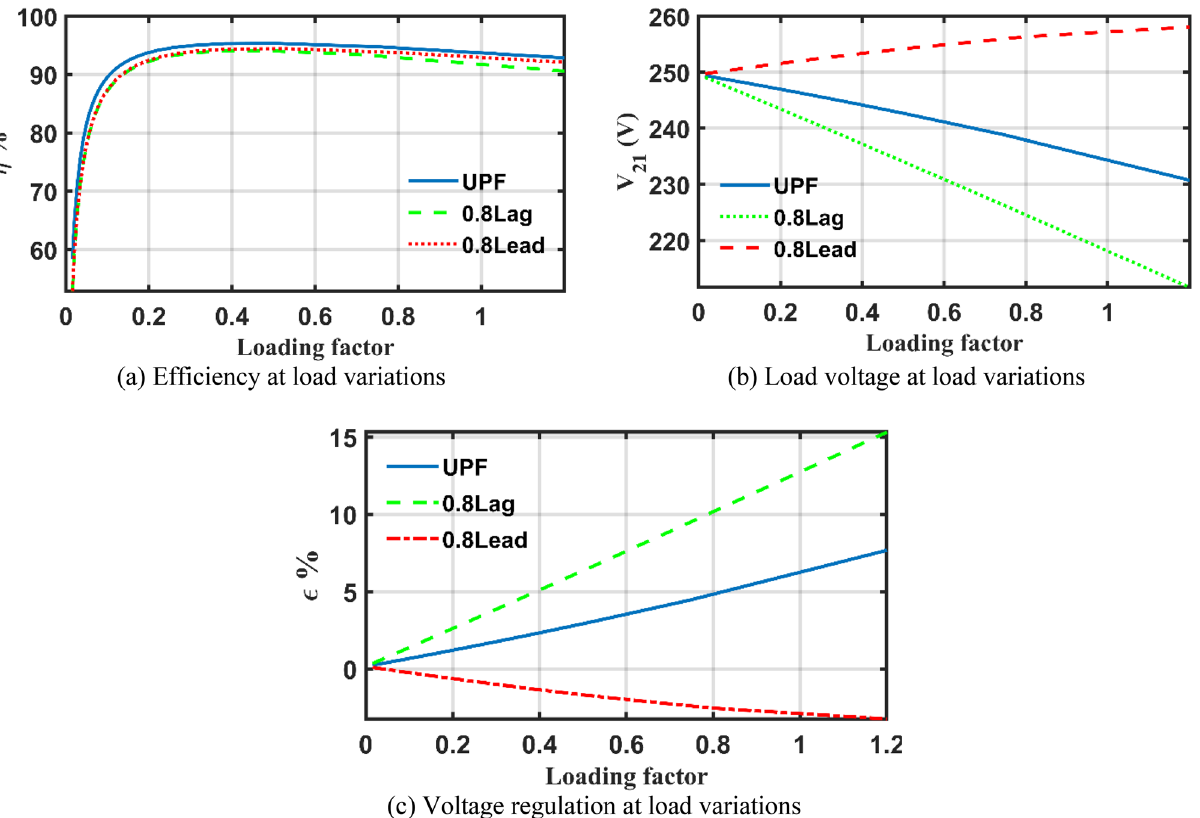
Figure 9. Case 2 transformer performance analysis utilizing AHO’s extracted parameters.